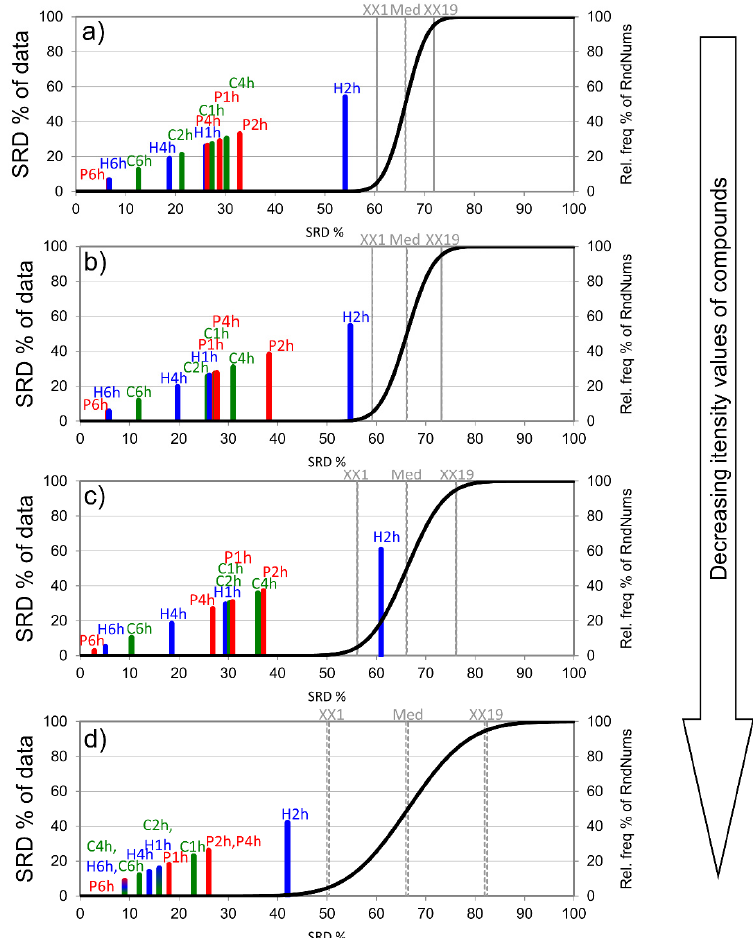
Figure 4. The scaled SRD values of the sampling procedure based on integrated peak area by sum of ranking differences. The maximum values of the compounds (Max) were used as the reference (benchmark) column. Scaled SRD values are plotted on the x-axis and left y-axis; the right y-axis shows the relative frequencies (black curve). Probability levels of 5% (XX1), median (Med), and 95% (XX19) are also given. If a model crosses the cumulative distribution function (XX1), say at p = 0.10, then the method ranks the variable as random with a 10% chance. Diagrams were produced according to intensity values: ( a ) all compounds (149), ( b ) the first 100 highest intensity compounds, ( c ) the first 50 highest intensity compounds, and ( d ) the first 20 most intensive compounds. Table 1. Identified volatile organic compounds in Lactuca sativa . Retention indices written in italics come from the NIST webbook. The 20 most intensive compounds are marked in bold. nd indicates no data. RT (Min) RI (Calculated) RI (Literature)